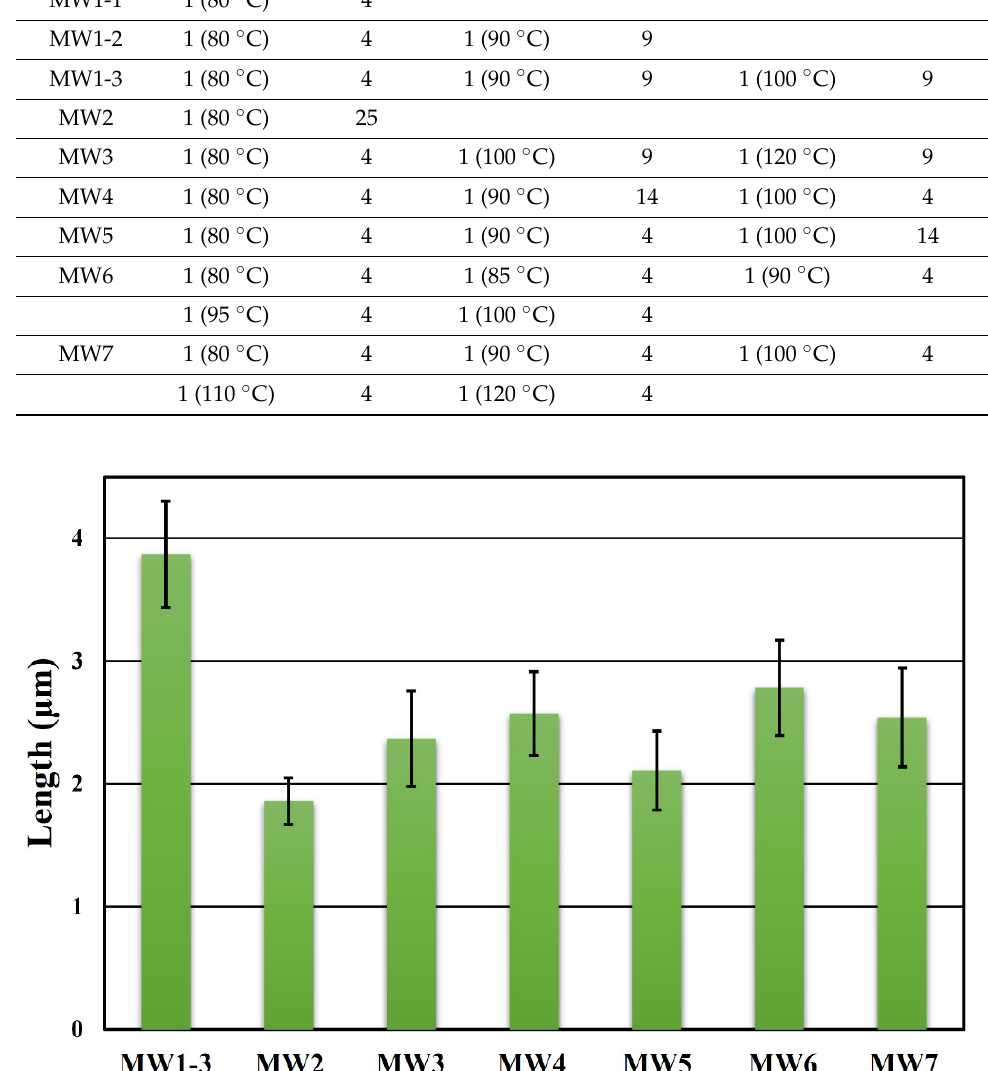
Figure 4. The average lengths of ZnO nanoneedle arrays at different temperature programming steps.